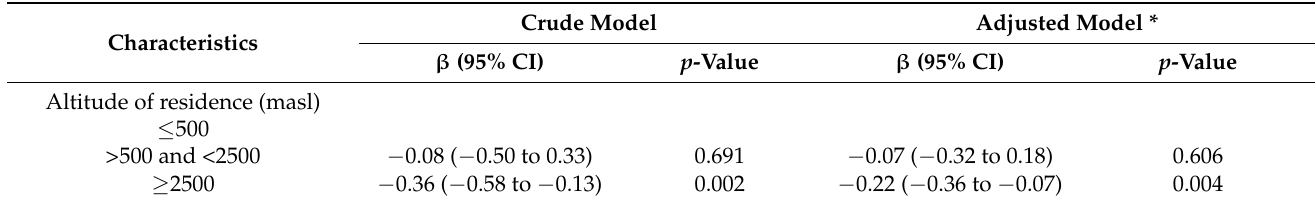
Table 4. Sensitivity analysis of the association between altitude and the Framingham risk score.